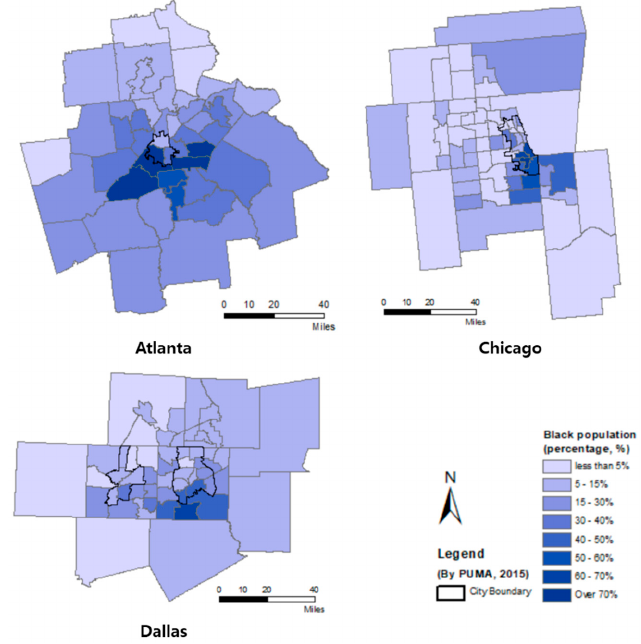
Figure 1. Black population percentage in the PUMA area, 2015.